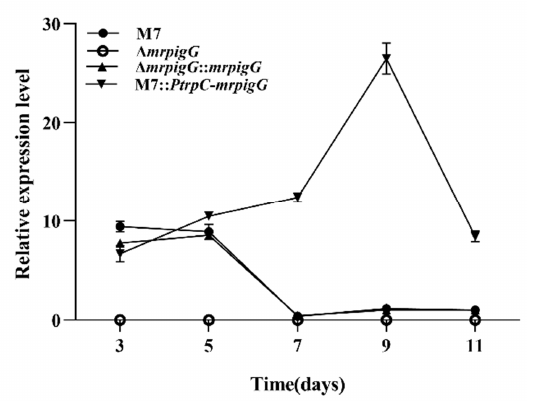
Figure 4. RT-qPCR analysis of the mrpigG gene in the mrpigG deletion strain, the mrpigG complementation strain, the mrpigG overexpression strain and the wild-type strain. 3.4. Morphologies and Biomasses of Δ mrpigG, Δ mrpigG::mrpigG, M7::PtrpC-mrpigG and M. ruber M7